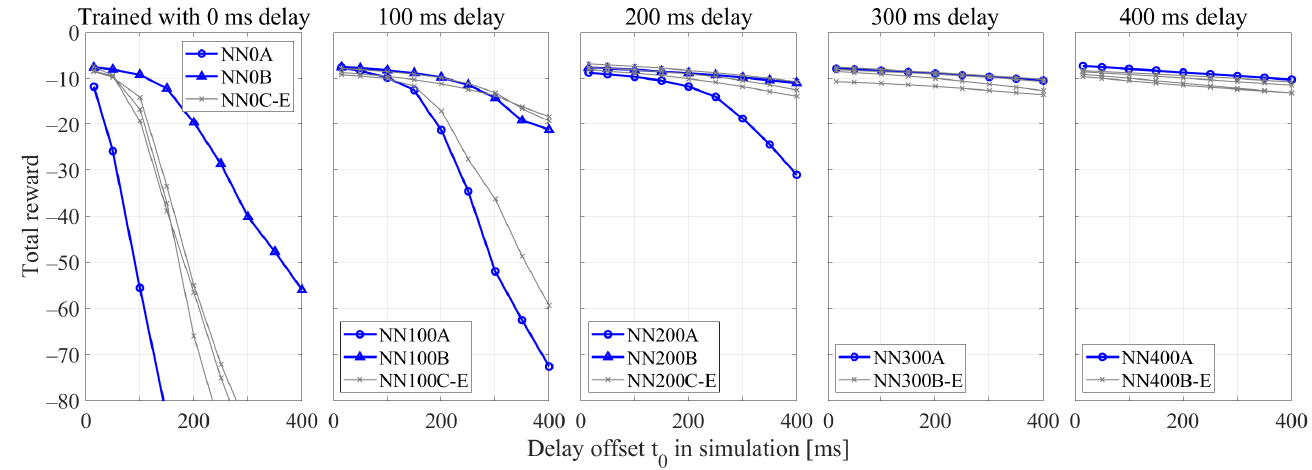
Figure 7. Simulated mean total reward for the doublet angle-of-attack schedule. Variations of the delay offset t 0 was